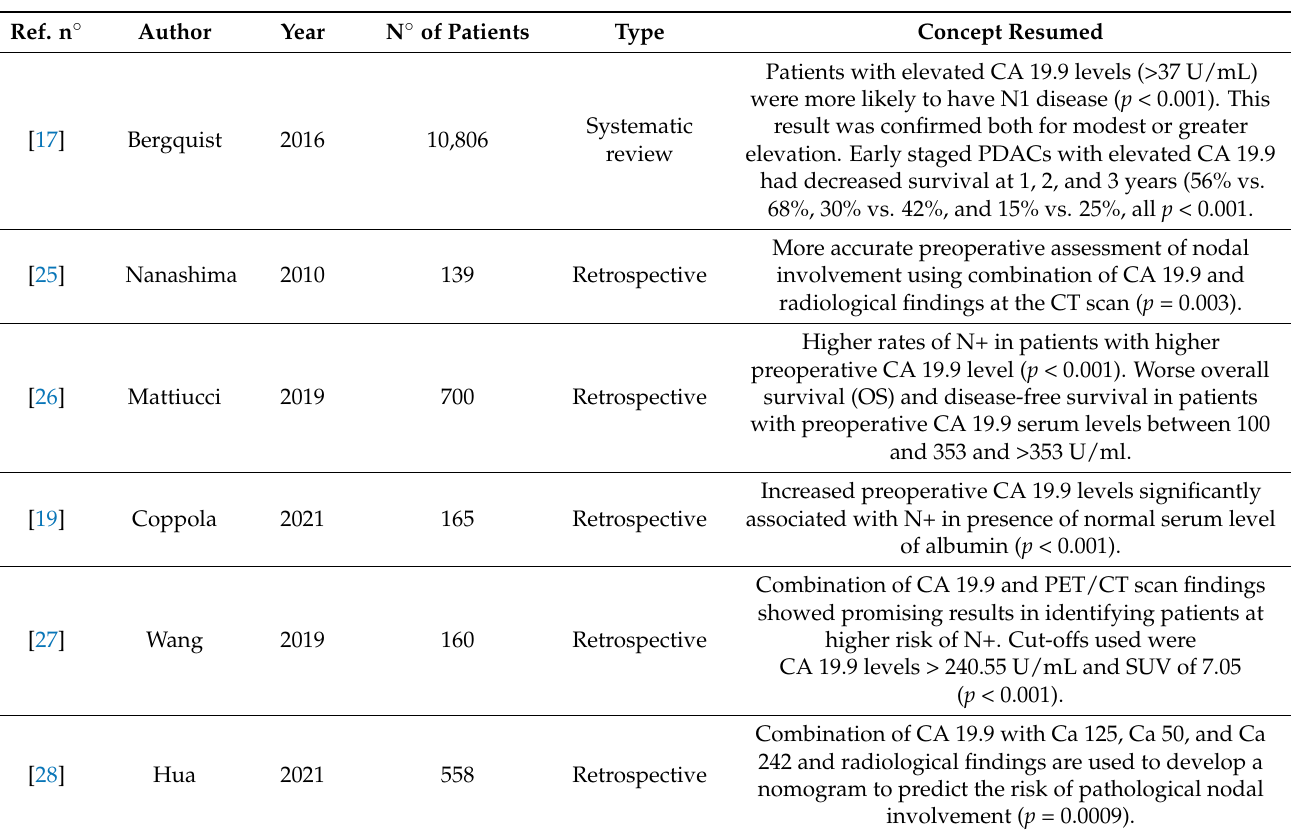
Table 1 reports the main characteristics and findings of the above-mentioned studies. Table 1. Main characteristics and findings of studies reporting data about association between CA 19.9 levels and nodal involvement.